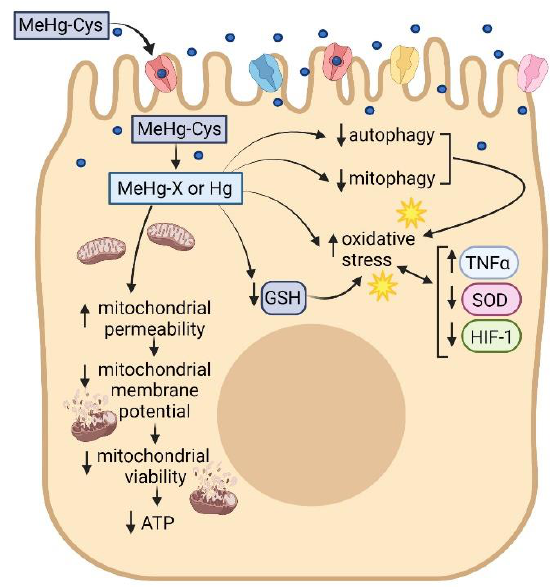
Figure 10. Uptake of MeHg-Cys by placental syncytiotrophoblasts leads to intracellular intoxication characterized by oxidative stress and mitochondrial dysfunction. This figure was created by BioRender.